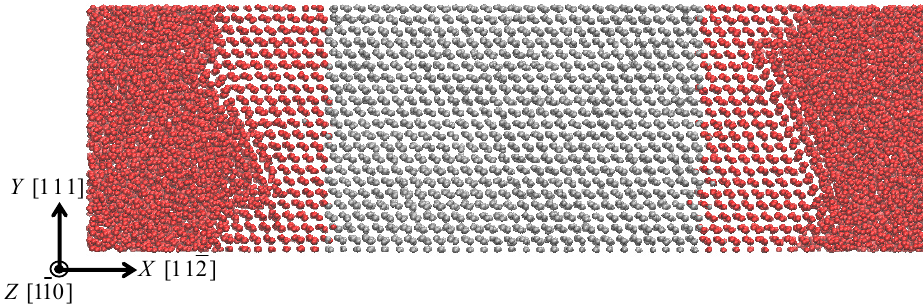
Figure 1. A snapshot of the simulation cell in running.